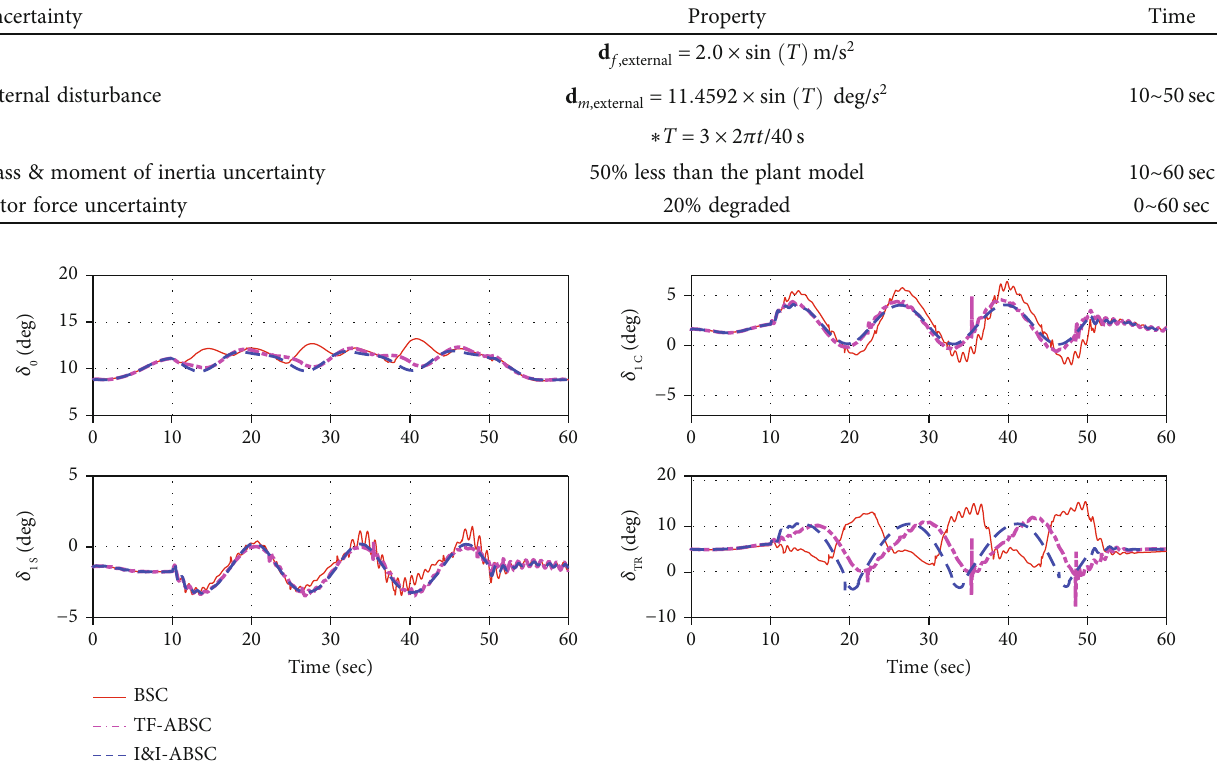
Table 2: Case B: disturbances & uncertainties.